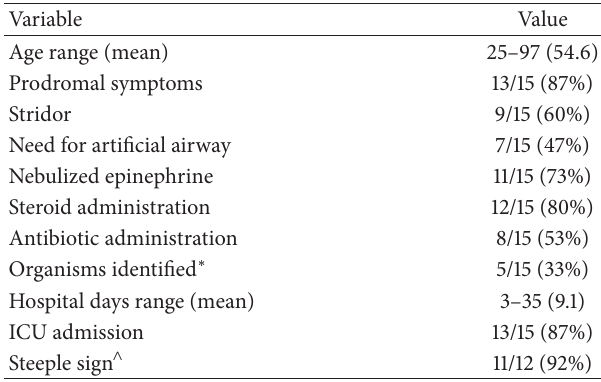
Table 1: Clinical characteristics of adult croup (15